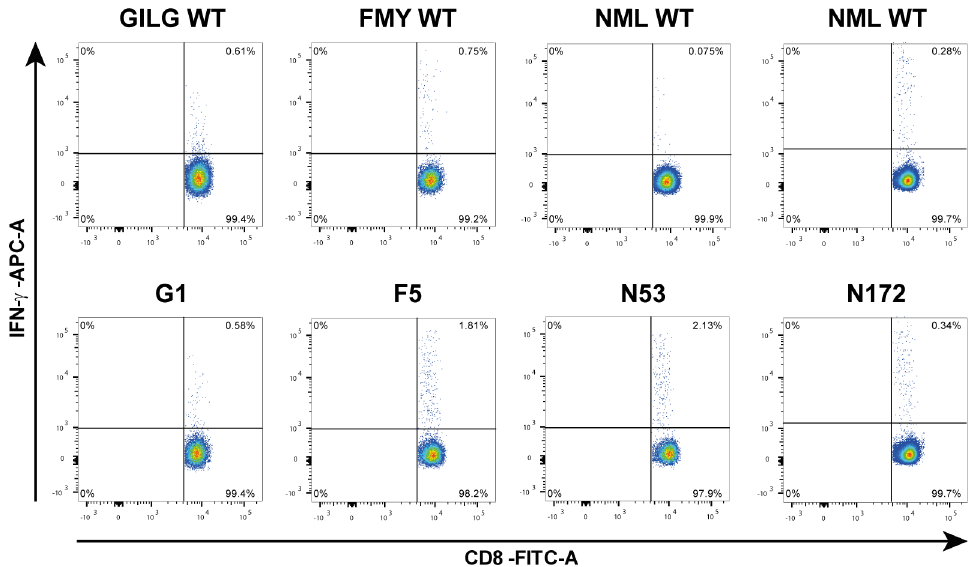
Fig 4. Flow cytometry analysis on CD8 + T cell responses of CPL- and WT-vaccinated mice. Dot plots showing IFN- γ production by CD8 + T cells of mice vaccinated with 75 nmol of either WT peptide or CPL (G1, F5, N53 and N172). In the upper panel, the respective WT-peptide control of that particular experiment is shown. In the lower panel, the CPL-induced IFN- γ responses are shown. Spleen cells (2 * 10 6 /well) were stimulated O/N with 1 nmol/well WT peptide. Highest responders of each group are shown. Vaccination with F5 and N53 induced the largest improvement in IFN- γ production compared to WT peptide-vaccinated mice. Negative control (mock stimulated splenocytes) had an average of 0.07% with a SD of